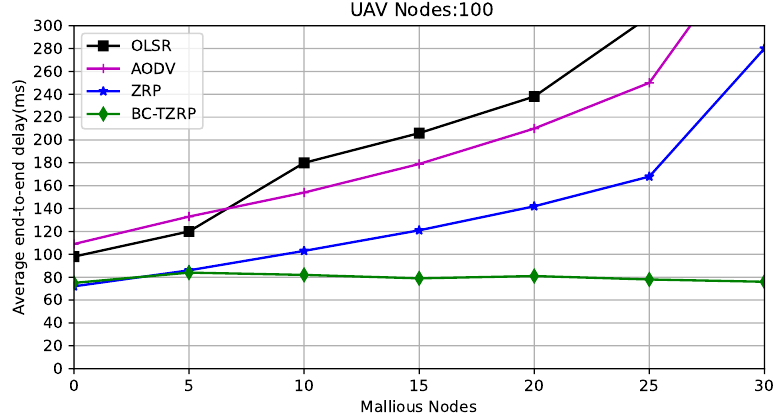
Figure 6. Avarage End-End delay for the case of progressively increasing fault